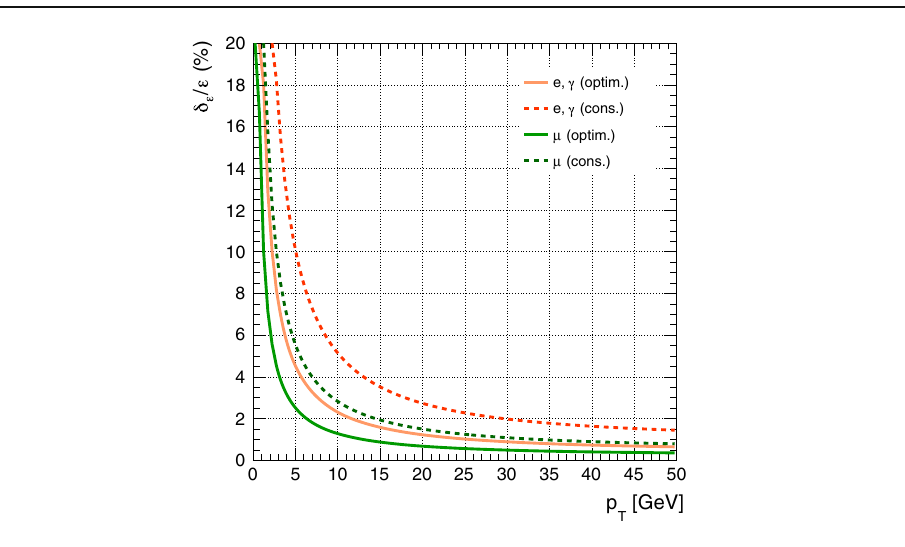
at the FCC-hh, due to the higher statistics that will allow statistically more powerful data-driven fine tuning. For example, imposing the identity of the Z boson rate in the ee and μμ decay channels will strongly correlate the e and μ efficiencies. The absolute uncertainty expected in the measurement of the production and decay rates for several final states (considering just the gg → H production channel) is shown in Fig. 4.5, as a function of the minimum p T of the event samples. The curves labeled by “stat+syst” include the optimal reconstruction efficiency uncertainties shown in Fig. 4.4. The curves labeled by “stat+syst+lumi” include a further 1%, to account for the overall uncertainty related to luminosity and production systematics. The luminosity itself could be known even better than that by using a standard candle process such as Z production, where